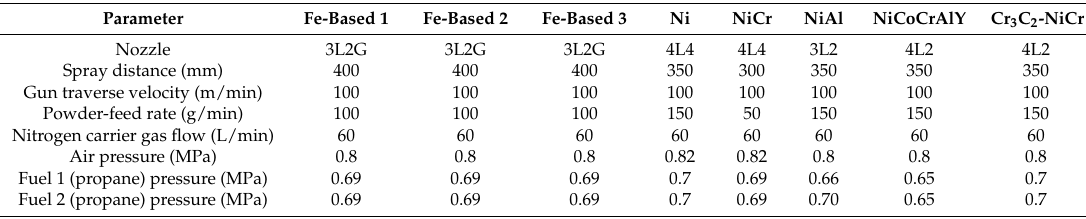
Table 2. HVAF process